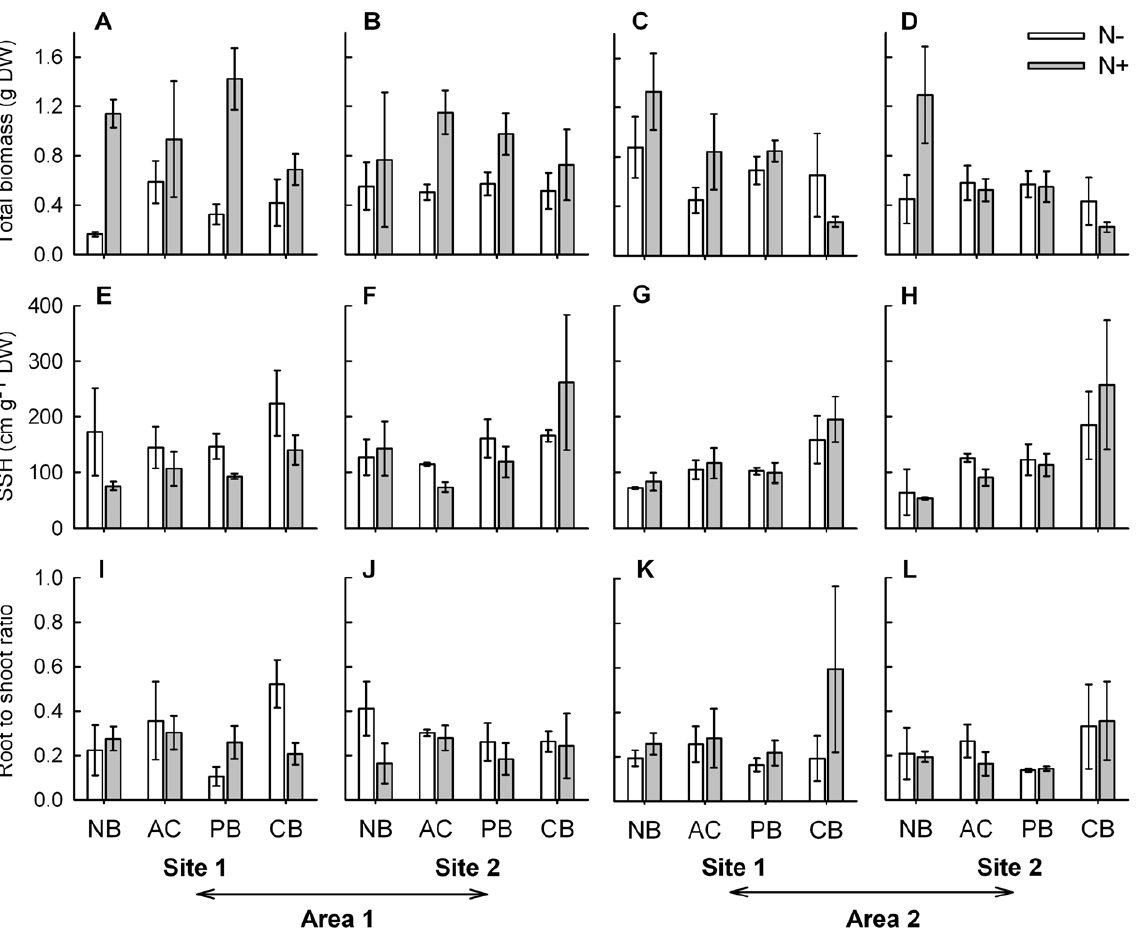
Figure 5. Total biomass, specific shoot height and allocation of Sporobolusvirginicus clones subjected to different treatments. Mean ( 6 1 SE) total biomass (A, B, C, D), specific shoot height, SSH (E, F, G, H), and root to shoot ratio (I, J, K, L) of plants grown in the two sites within each of the two areas. N 2 = no nutrient added, N + = nutrient addition; NB = no burial, AC = artifact control, PB = partial burial, CB = complete burial.